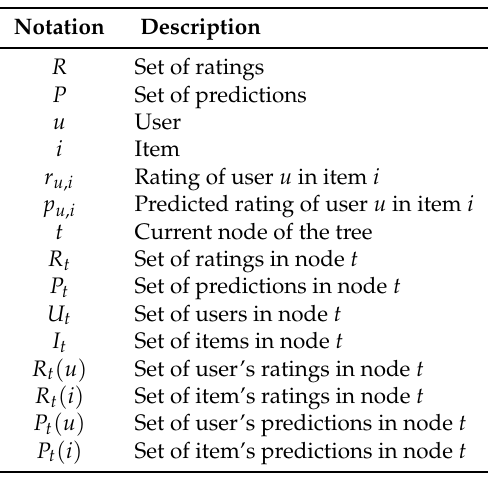
Table 1. Notation used in decision